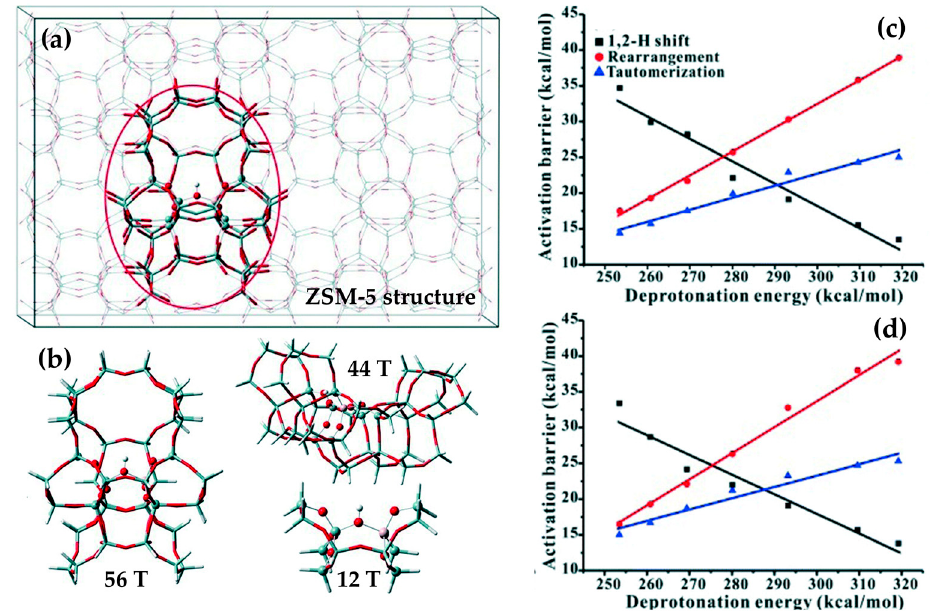
Figure 10. The cluster used for a 56 T model of ZSM-5 ( a ). The different cluster-sizes used to evaluate the influence of spatial constraints ( b ). The influence of acid-site strength on the energetics of the Beckmann rearrangement of cyclohexanone oxime ( c ) and for acetoxime ( d ) (modified from references 107,108).